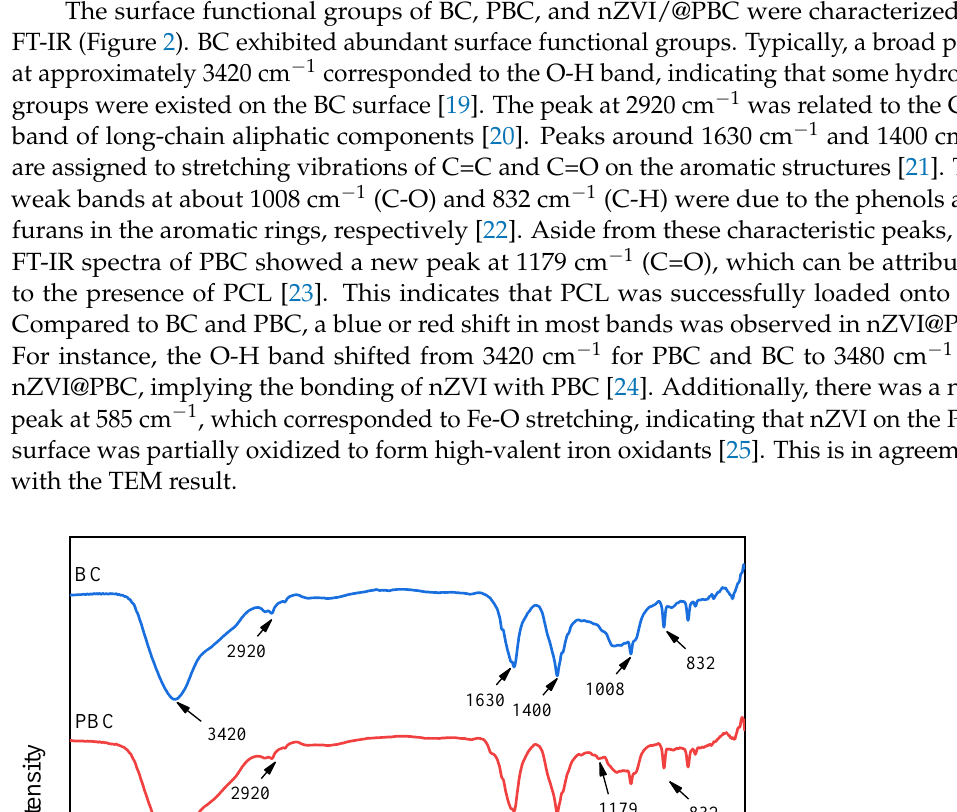
Figure 1. SEM images of BC ( a ), PBC ( b ), and nZVI@PBC ( c ).